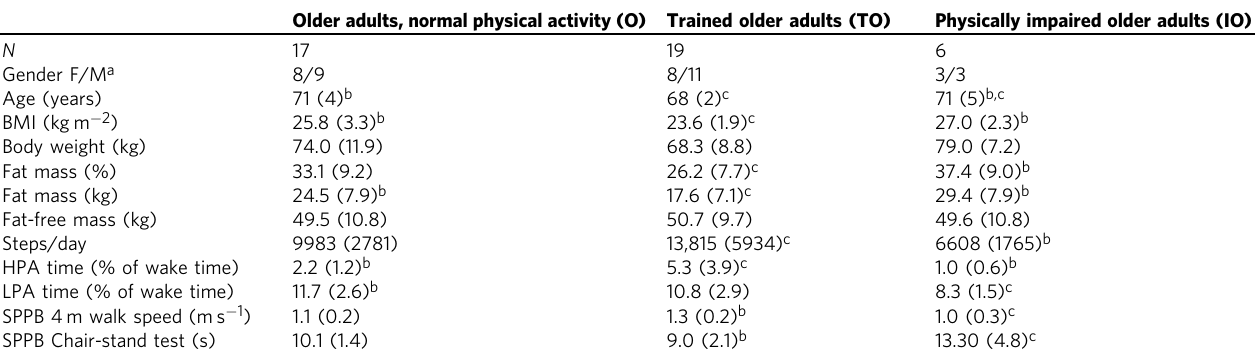
Table 2 Participant body composition characteristics, physical activity, and physical function. Older adults, normal physical activity (O) Trained older adults